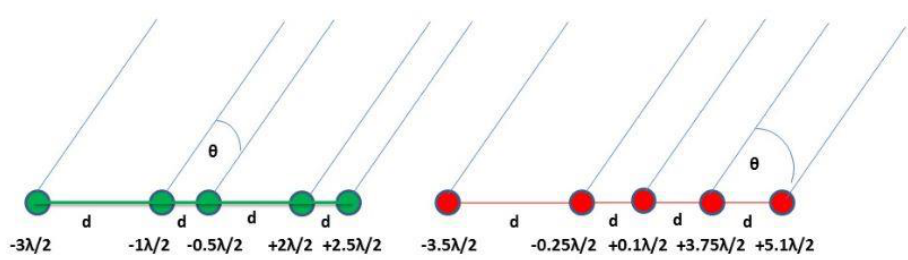
Figure 1. Doublet linear antenna array comprising of two LAs.